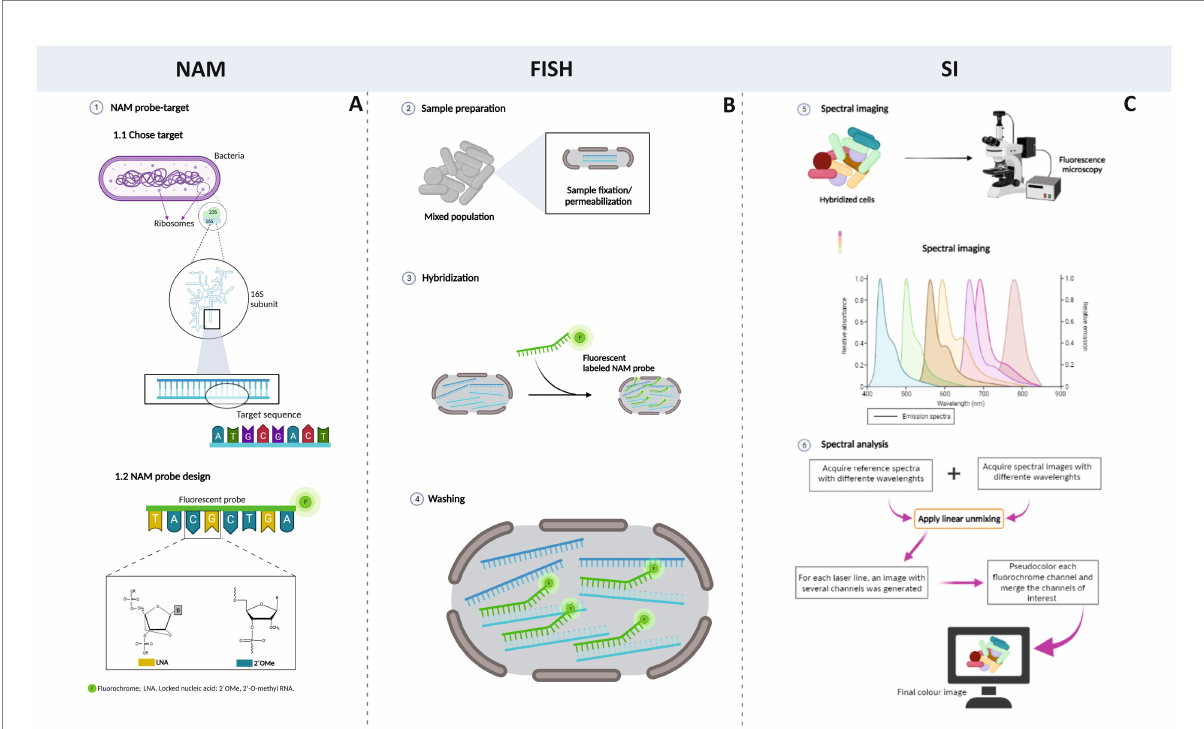
FIGURE 6 Schematic representation of SI-NAM-FISH. The first step involves the selection of the target and the design of the NAM probe (A) ; then, the FISH procedure (B) is optimized. For that, the sample is fixed and permeabilized to preserve the cell structure and to ensure the probe entry into the cells. Then, a specific fluorescent NAM probe binds to rRNA that exist in high copy number within the cell; afterward, the washing step allows to remove the unbound NAM probe or the excess of the probe. The panel B illustrates the hybridization process for one probe; however, in the present work, a multiplex approach is applied. As different fluorochromes present a certain degree of the overlapping emission spectra, the spectral imaging strategy is used (C) . The sample is illuminated sequentially with each wavelength excitation (in order of descending wavelength of the excitation laser light). Images are processed by applying a linear unmixing algorithm with reference spectra for each excitation wavelength. This process compiles each single-labeled bacteria image in a final common image where different species are